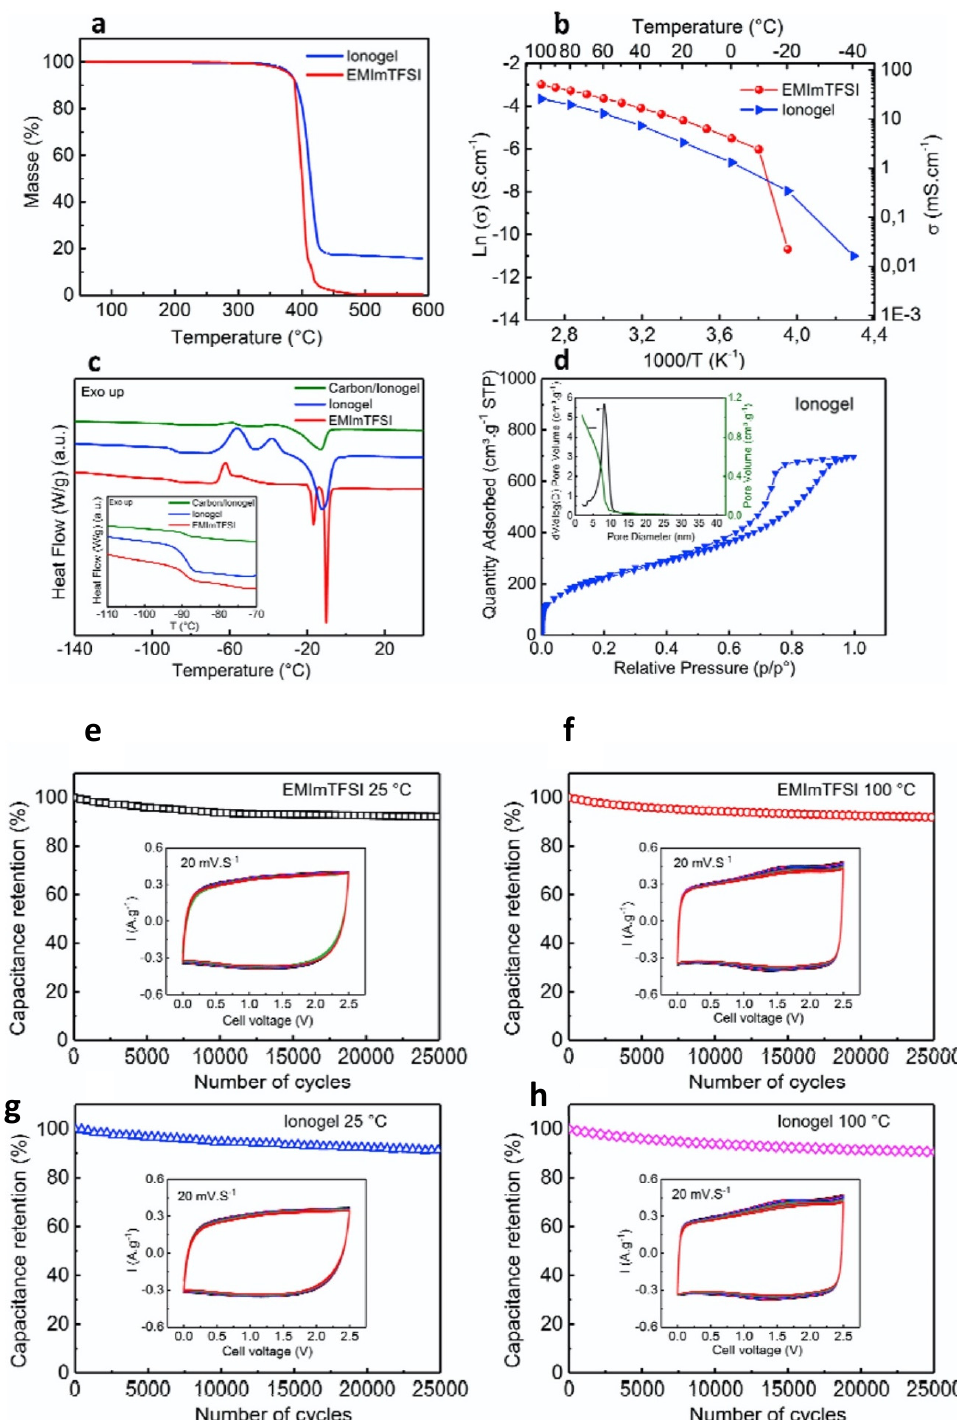
Figure 7. ( a ) TGA showing the thermal stability of the pristine IL and of the IL–based gel; ( b ) con- ductivity versus temperature; ( c ) DSC profiles of the IL and of the IL-based gel; ( d ) N 2 adsorp- tion/desorption isotherm; inset: BJH pore size distribution for the IL-based gel after IL extraction. Galvanostatic cycling with potential limitation (GCPL) data at room temperature ( e , g ) and 100 °C ( f , h ) for EDLCs using IL ( a , b ) and IL-based gel electrolytes (c, d); insets: CV at 20 mV s –1 recorded after every 1000 GCPL cycles; at the 25,000th cycle, the charge efficiency is 78, 85, 73, and 83% for e, f, g, and h, respectively. Reprinted with permission from ref.